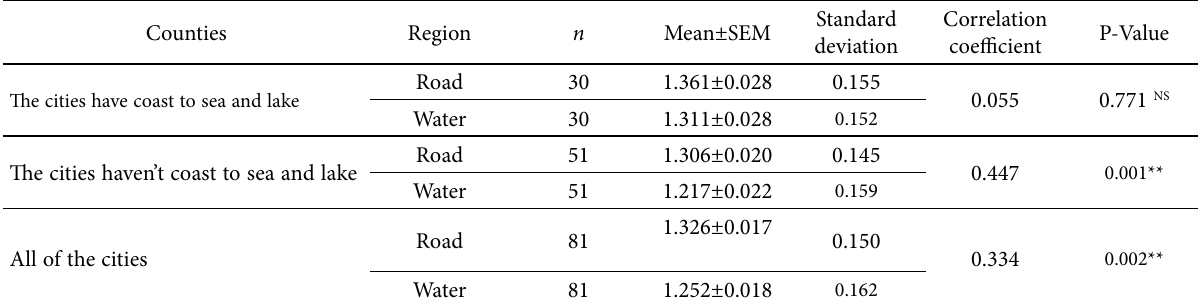
Table 5. Pearson correlation coefficients of fractal value between water and road Counties